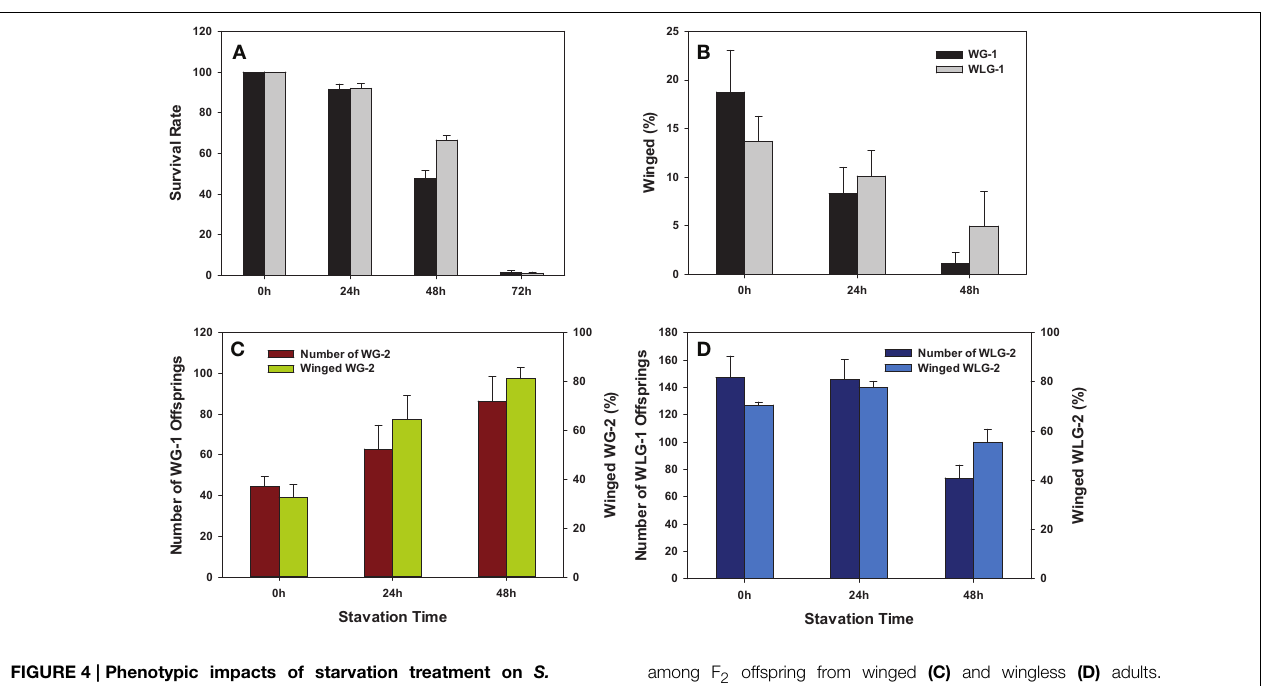
among F 2 offspring from winged (C) and wingless (D) adults. WG-1/2: winged F 1 /F 2 population; WLG-1/2: wingless F 1 /F 2